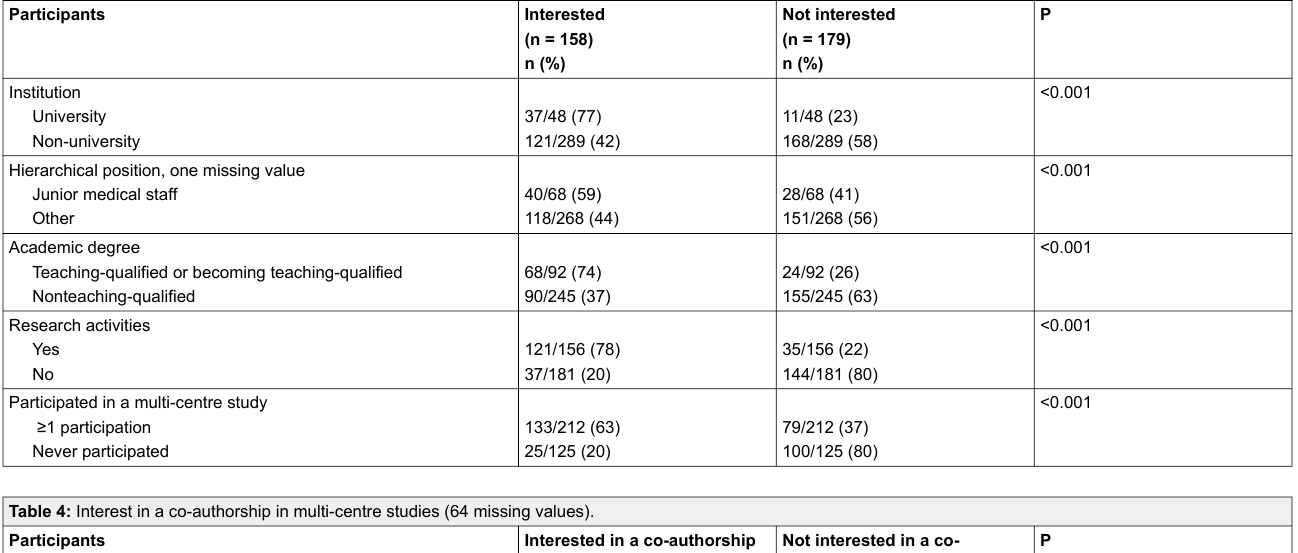
Table 4: Interest in a co-authorship in multi-centre studies (64 missing